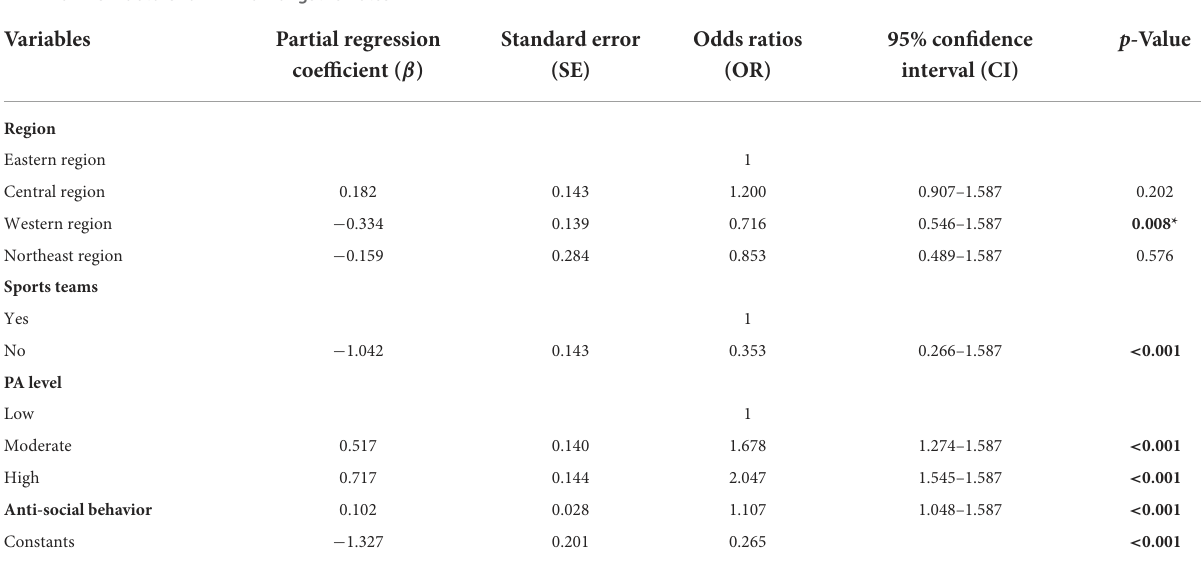
TABLE 5 Risk factors for PARI amongst